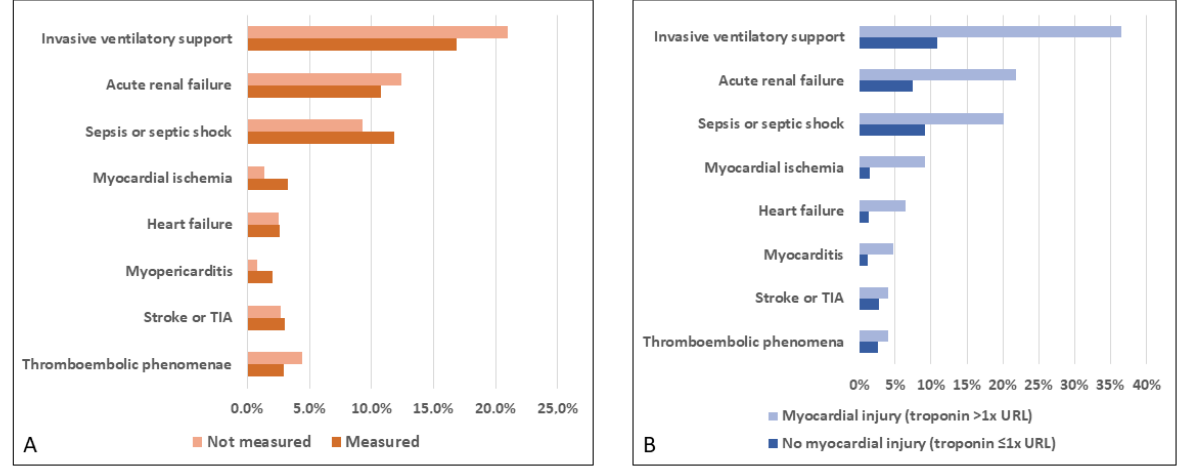
Figure 3. Complications according to ( A ) troponin measurement ( n = 3246) and ( B ) myocardial injury ( n = 1476) in the first week of hospitalization. TIA, transient ischemic attack; URL, upper reference limit.